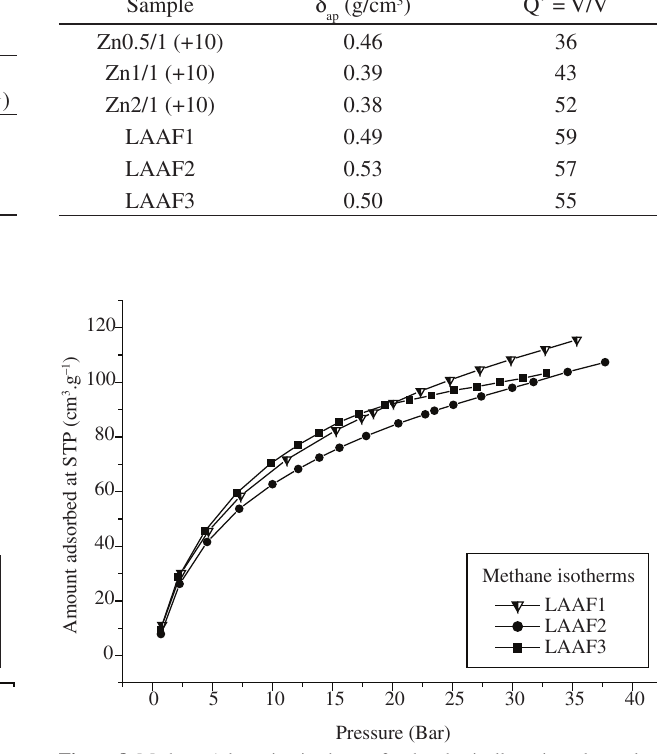
Figure 8. Methane Adsorption isotherms for the physically activated samples. 2